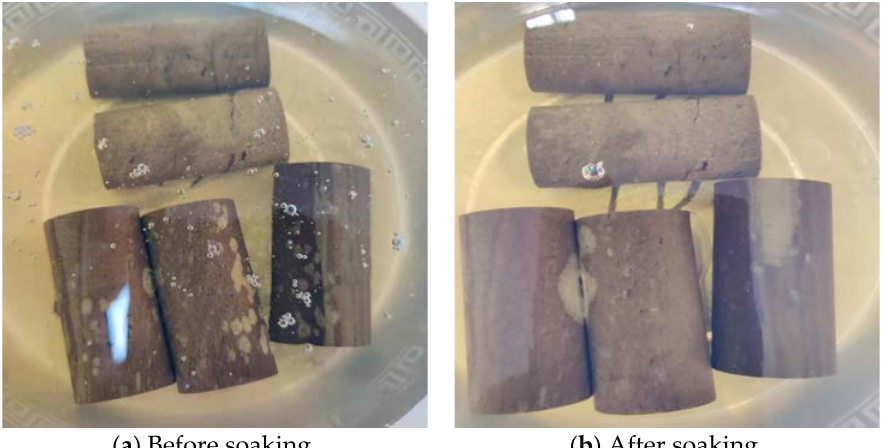
Figure 6. Soaking in diesel oil for 48 h.